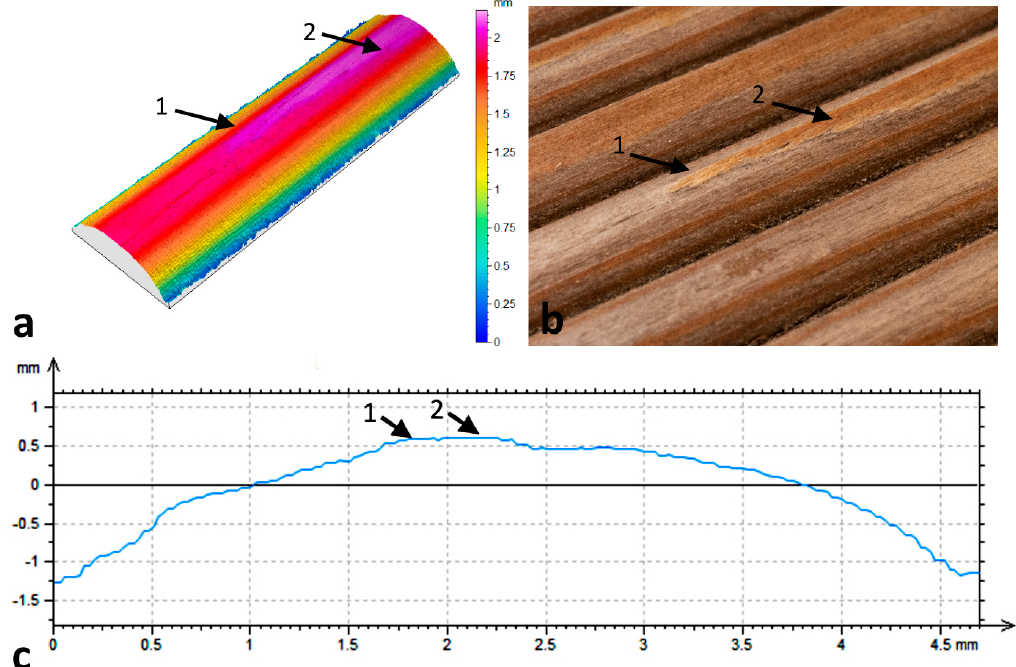
Figure 8. Tip of a growth ring raised above the peak of a profiled (short rib) western larch deckboard with growth rings oriented bark-side-up and exposed to the weather for seven months in Vancouver, Canada: ( a ) confocal profilometry height map of a latewood tip; ( b ) photograph of a latewood tip matching the image in Figure 8a; and, ( c ) confocal profilometry line trace showing variation in height of the arrowed rib in Figure 8b.